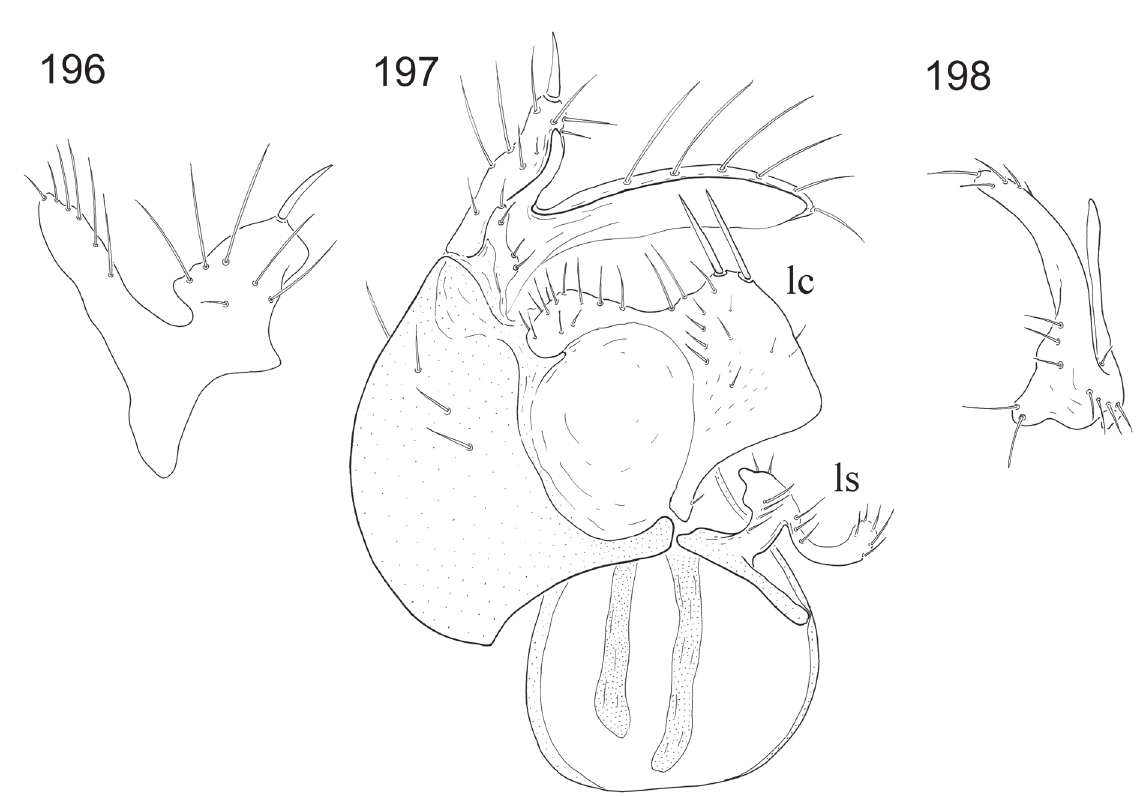
Figs 196-198. Nanodromia taksin Grootaert & Shamshev, 2003, ♂ terminalia. 196 . right surstylus, dorsal view. 197 . epandrium with cerci, dorsal view. 198 . left surstylus, lateral view. (after Grootaert & Shamshev